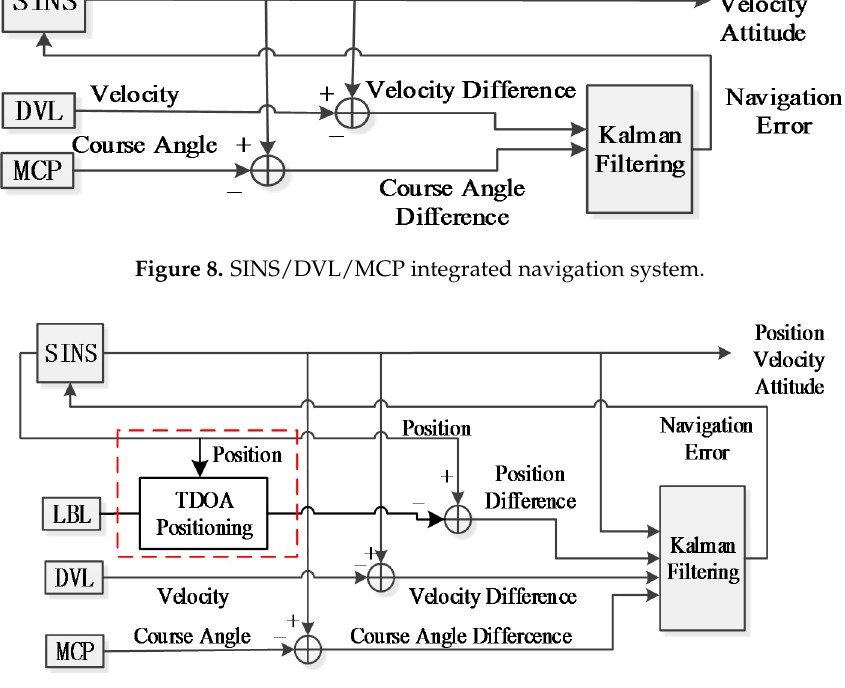
Figure 9. SINS/DVL/MCP/LBL integrated navigation system.